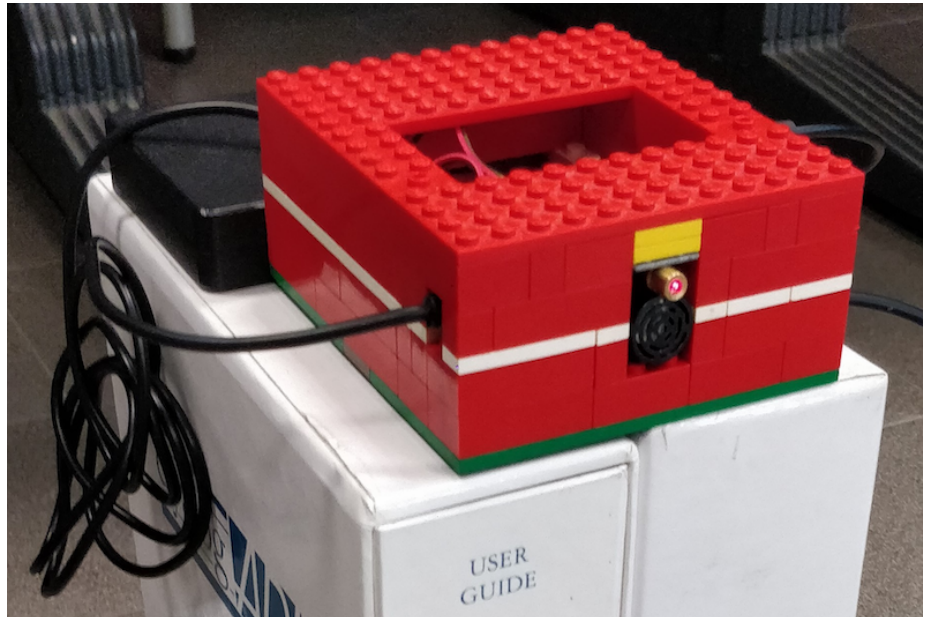
Figure 4. IoT node defined for the experimental characterization campaigns, composed by a Rasp- berry Pi 3 Model B+, an ultrasonic sensor, and a laser